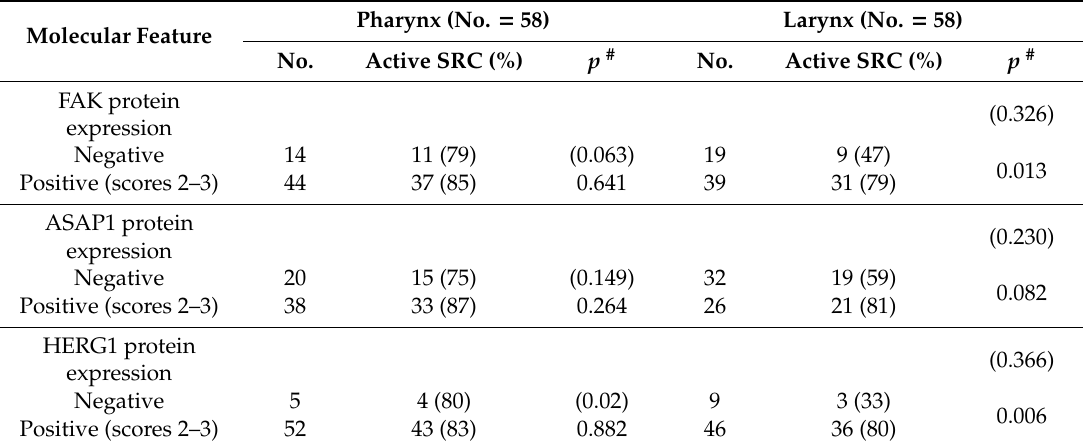
Table 4. Associations between active SRC expression and SRC-related proteins by tumor site. Molecular